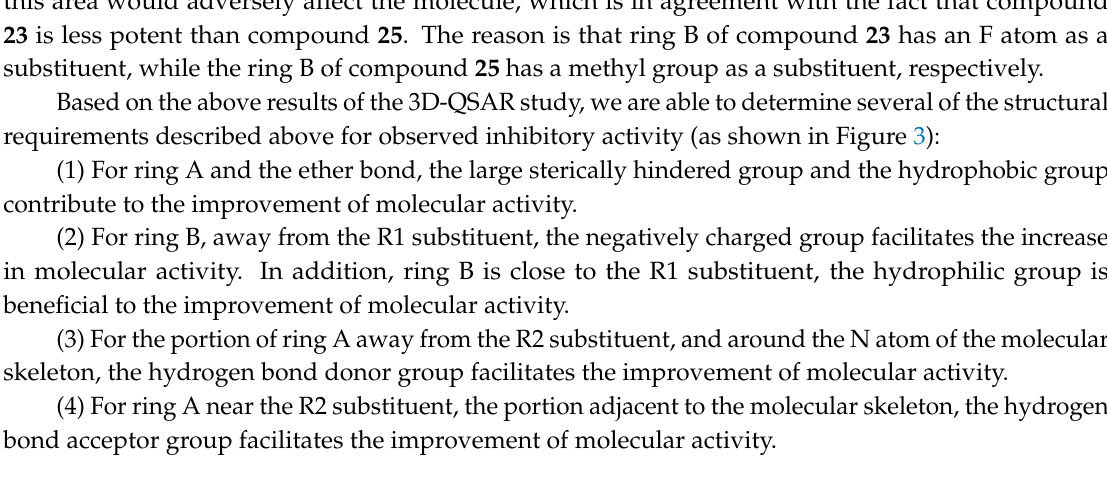
Molecules 2020 , 25 , x FOR PEER REVIEW 5 of 23 Figure 2. CoMSIA StDev*-Coeff contour map. ( A ) Steric contour map: the green contours represent regions where bulky groups increase the activity, the yellow contours represent regions where bulky groups decrease the activity; ( B ) electrostatic contour map: the blue contours indicate regions where electropositive features promote the activity, the red contours indicate regions where electronegative features promote the activity; ( C ) hydrophobic contour map: the white contours indicate regions where hydrophobic groups are detrimental for the activity, the yellow contours indicate regions where hydrophobic groups are beneficial for the activity; ( D ) H-bond donor contour map: the cyan contours represent regions where H-bond donors promote the activity, the purple contours represent regions where H-bond donors demote the activity; ( E ) H-bond acceptor contour map: the purple contours represent the regions where H-bond acceptors are beneficial for the activity, while the red contours represent the regions where H-bond acceptors are detrimental to the activity. Figure 2A shows the effect of the sterically hindered field on the molecular activity, where the green cloud indicates that the introduction of large substituents in this region will lead to the increase of the activity of the antagonist, which can be verified from the sample dataset in Appendix A of Supplementary material. For example, compounds 6 ( pIC (cid:2873)(cid:2868) = 7.57 ) and 8 ( pIC (cid:2873)(cid:2868) = 6.49 ) have similar structures. However, compound 6 has a greater steric hindrance than compound 8 on the substituent at position 20 of ring A, resulting in an increase in antagonistic activity. Further, the